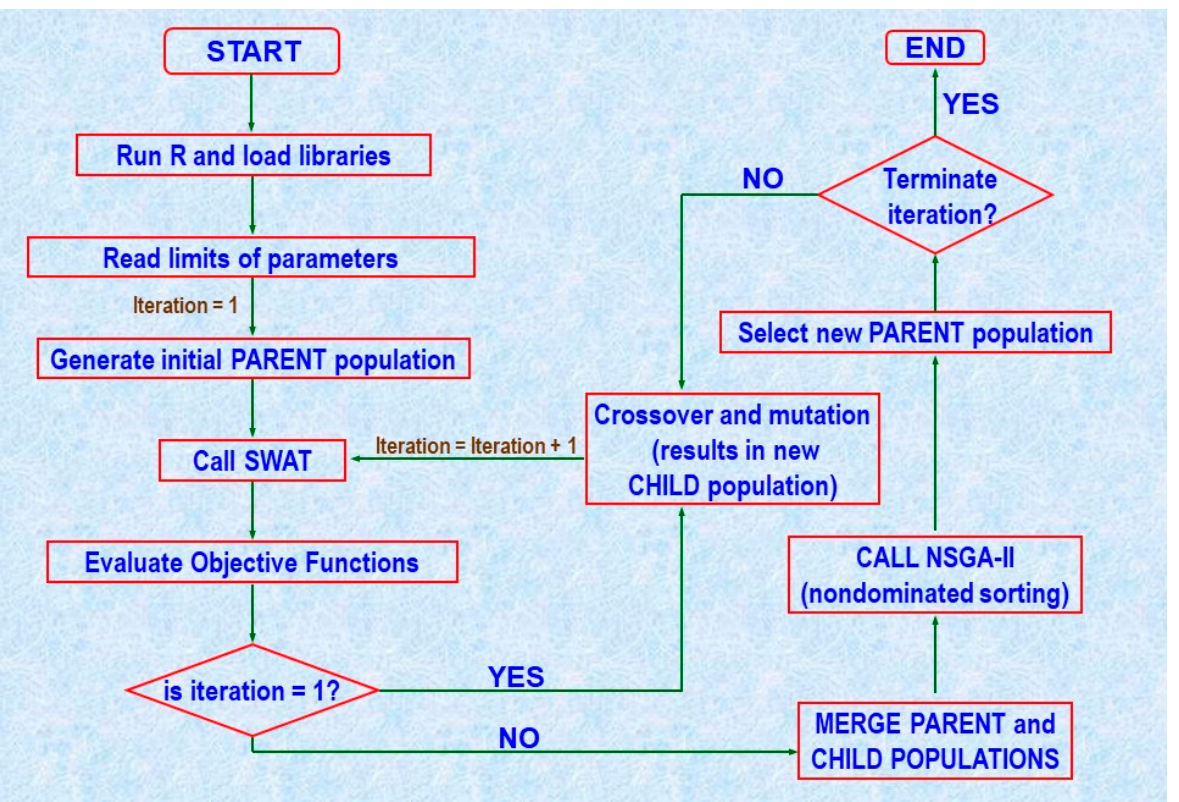
Figure 2. Calibration algorithm for SWAT (modified after Confesor and Whittaker 2007).